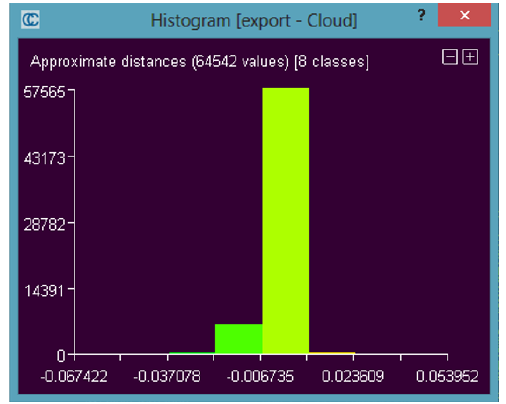
Figure 7. Histograms comparison of the point clouds